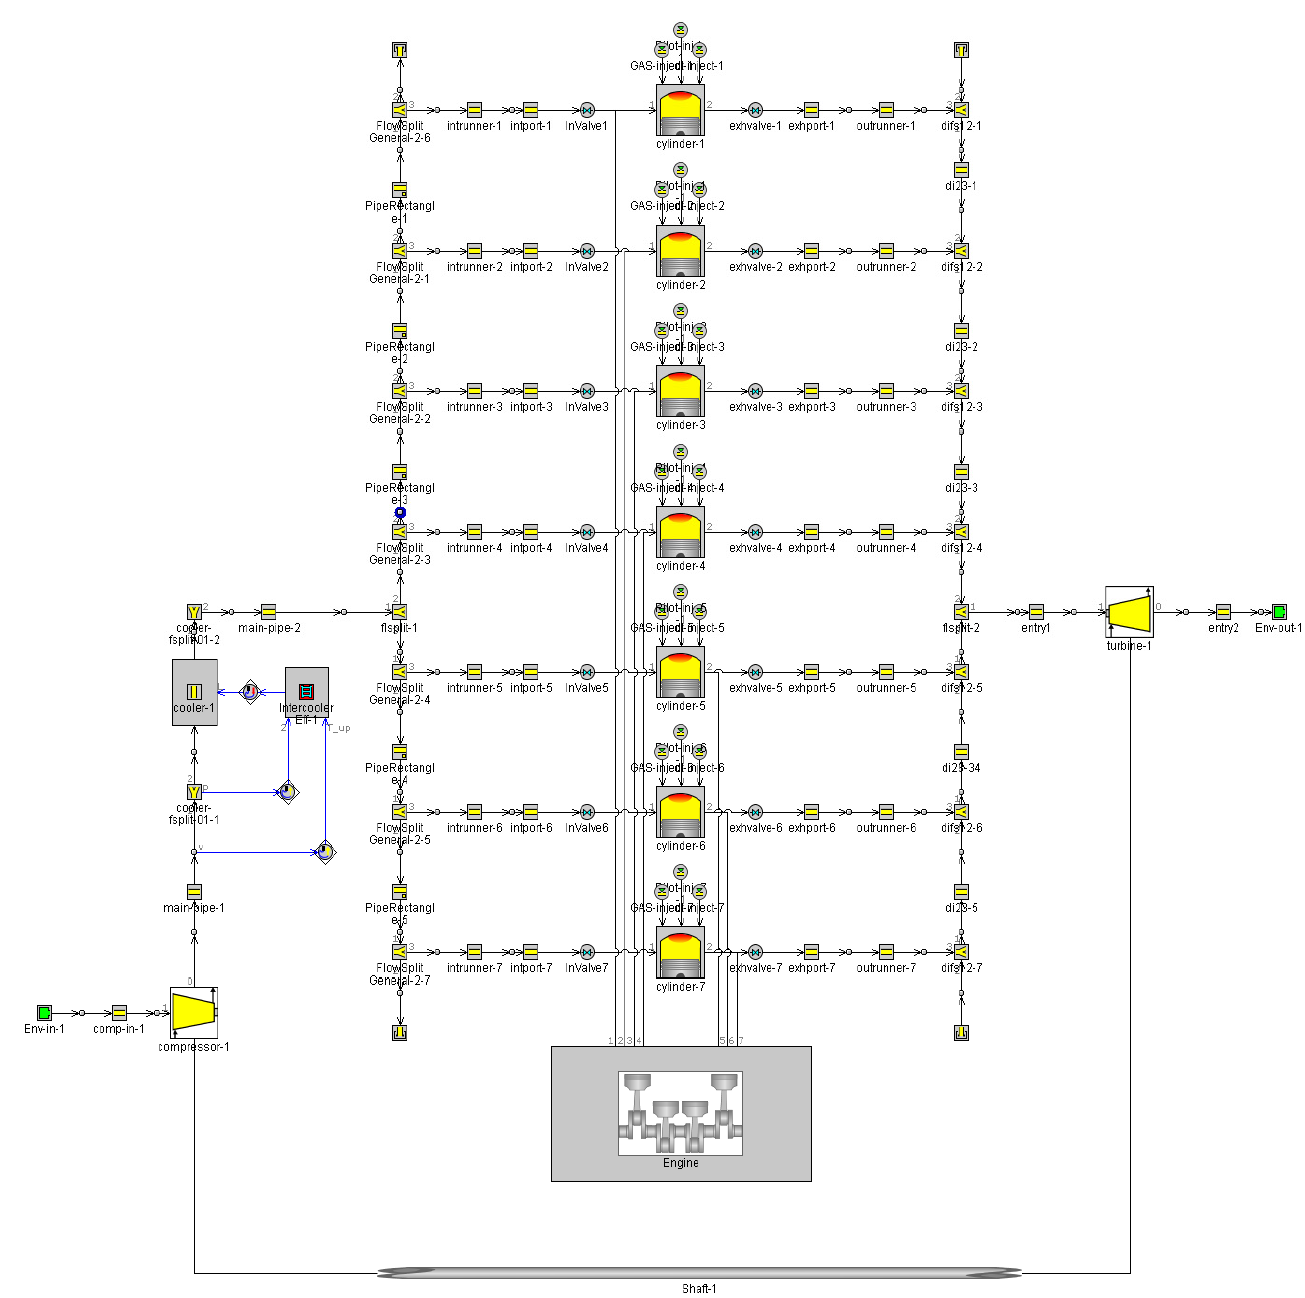
Figure 2. 7X82DF simulation model in GT Power.